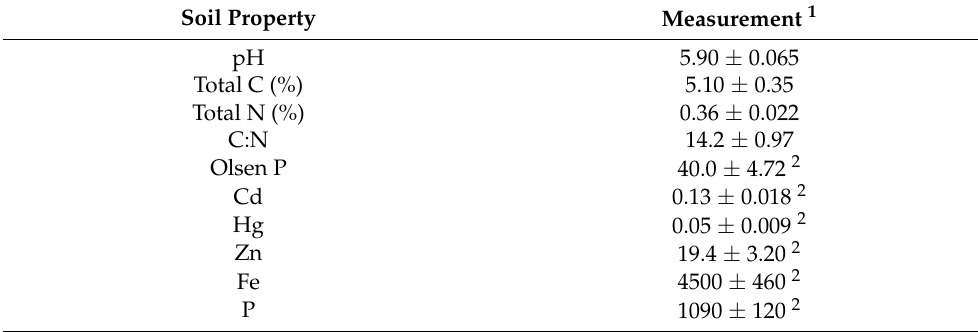
Table 1. Soil samples’ physicochemical properties for the soil used in